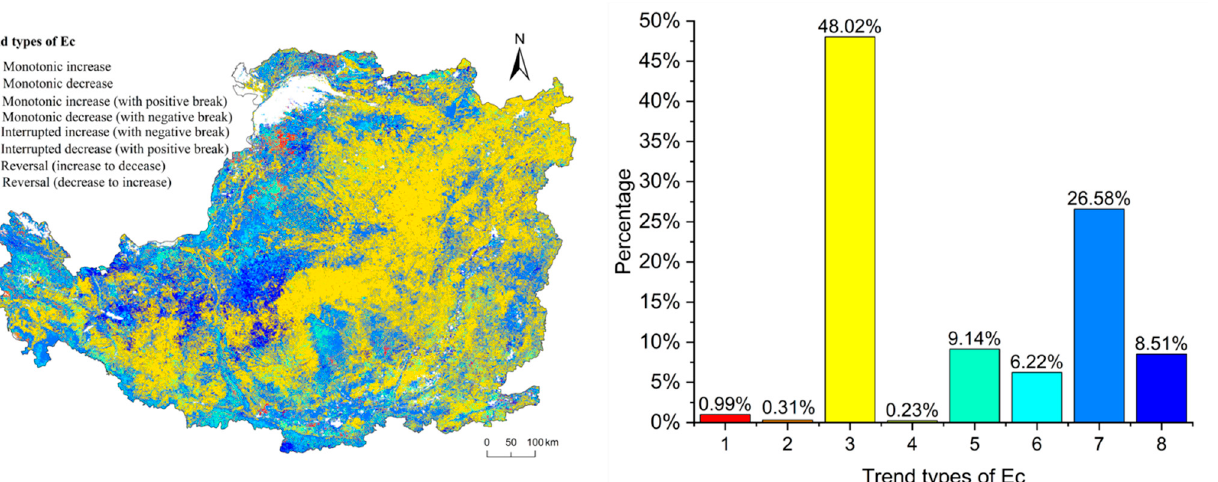
Figure 6. Spatial distribution and the percentage of different types of GPP.